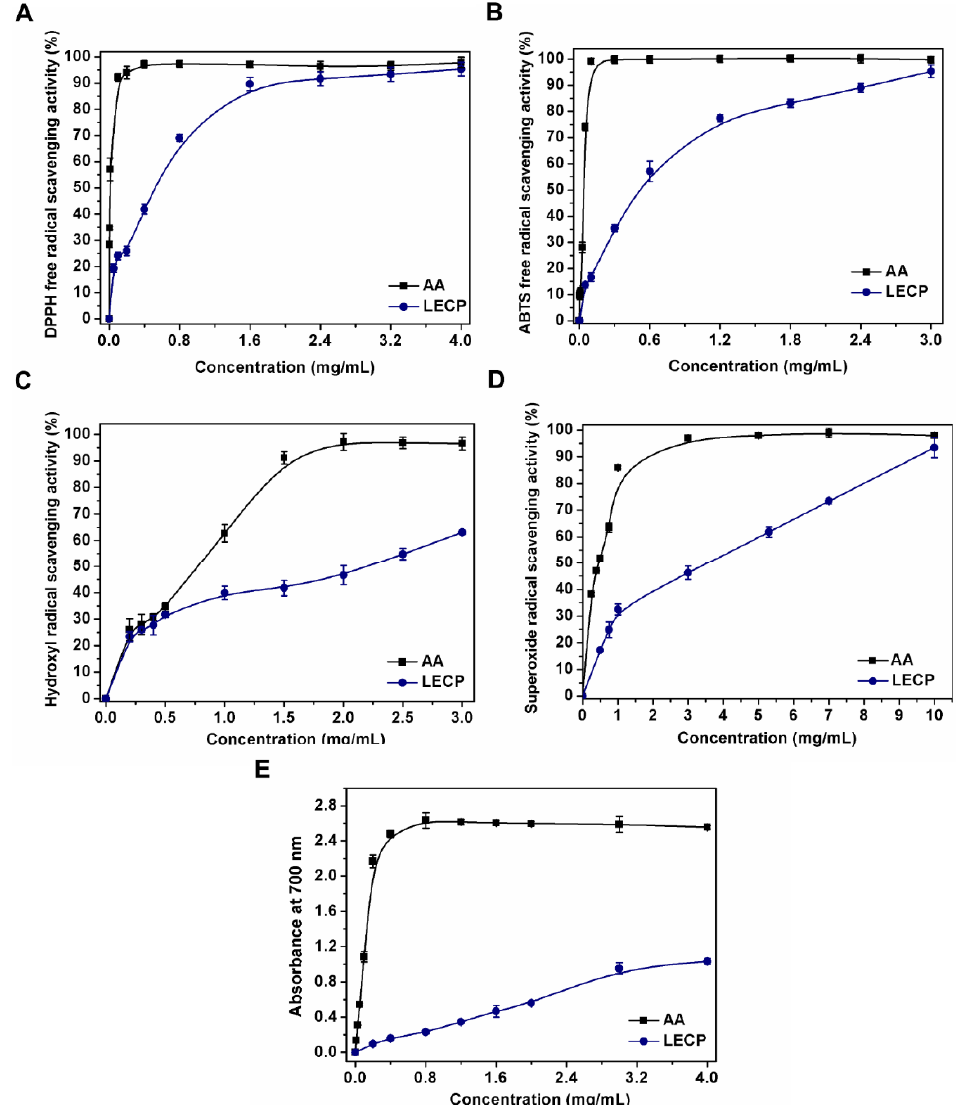
Figure 3. Antiradical activity of LECP and AA: DPPH radical scavenging activity ( A ), ABTS radical scavenging activity ( B ), hydroxyl radical scavenging activity ( C ), superoxide radical scavenging activity ( D ) and reducing power ( E ).